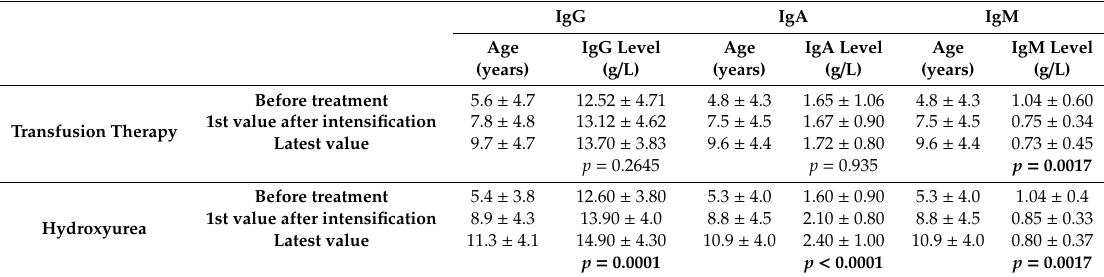
Data are mean ± SD. Bold values indicate significance at p < 0.05.